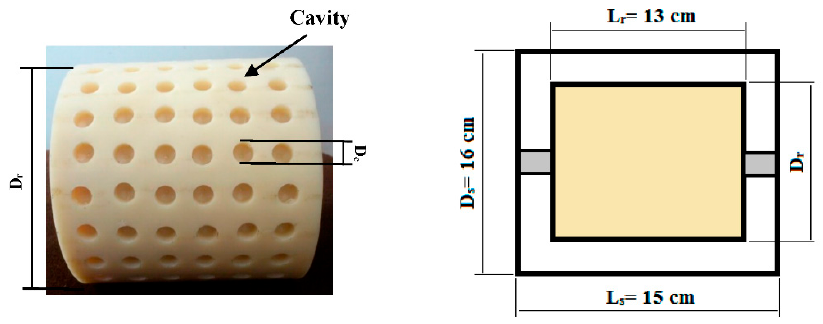
Figure 2. Dimensions of the rotor and stator in SPR reactor.